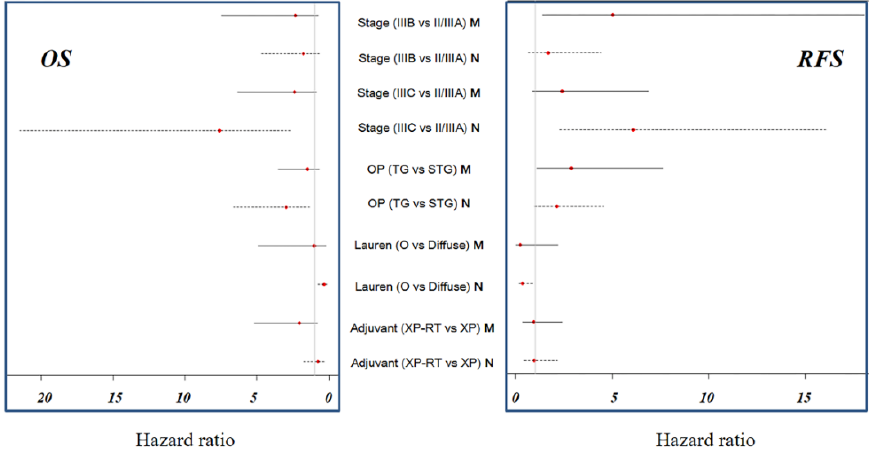
Figure 3. Forest plot for adjusted RFS and OS. No significant differences in RFS related to the use of adjuvant XP-RT or XP for the mesenchymal and non-mesenchymal subtypes were detected (OP, operation; TG, total gastrectomy; STG, subtotal gastrectomy; O, others, M, mesenchymal subtype; N, non-mesenchymal subtype) .